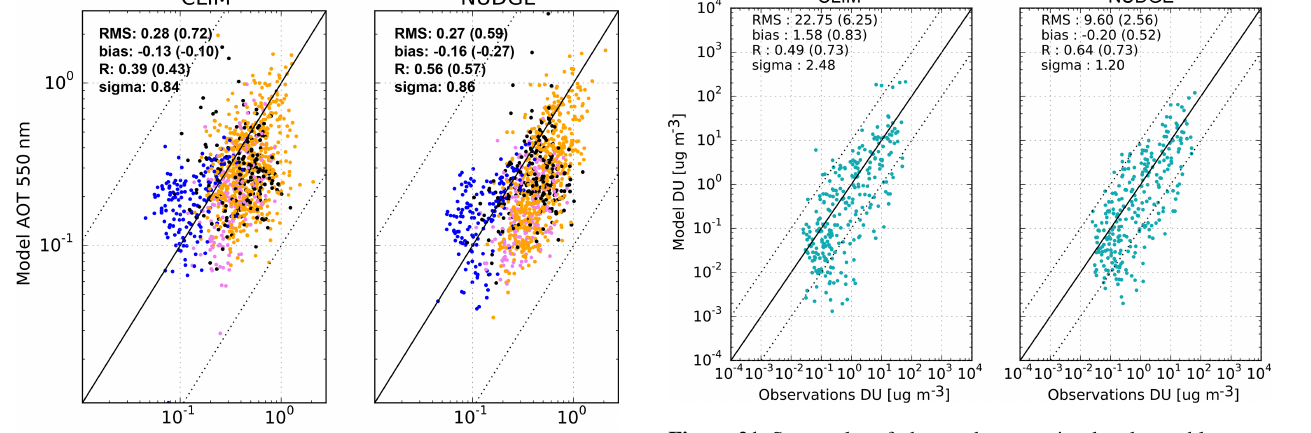
Figure 21. Scatterplot of observed versus simulated monthly mean dust surface concentrations at the AEROCE and SEAREX stations shown in Fig. 17. Simulated monthly means were constructed from the daily mean outputs sampled on the same days of the observa- tions and collocated to the observation position for the time period